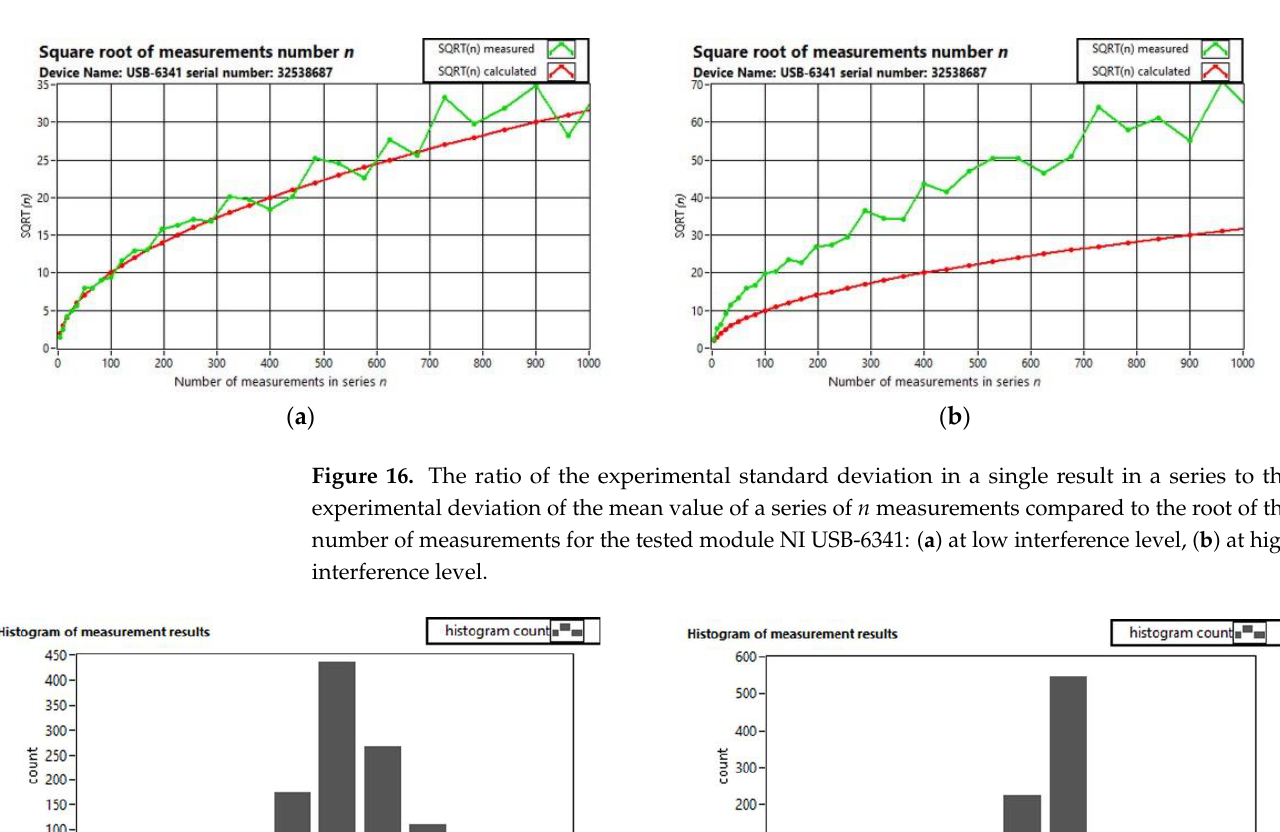
interference level.